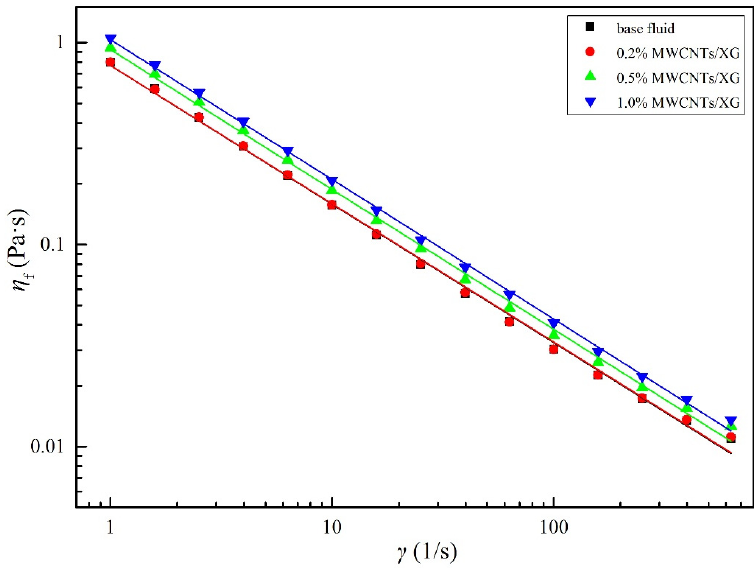
Figure 5. Variation of the viscosity with the shear rate at different concentrations at 25 °C.